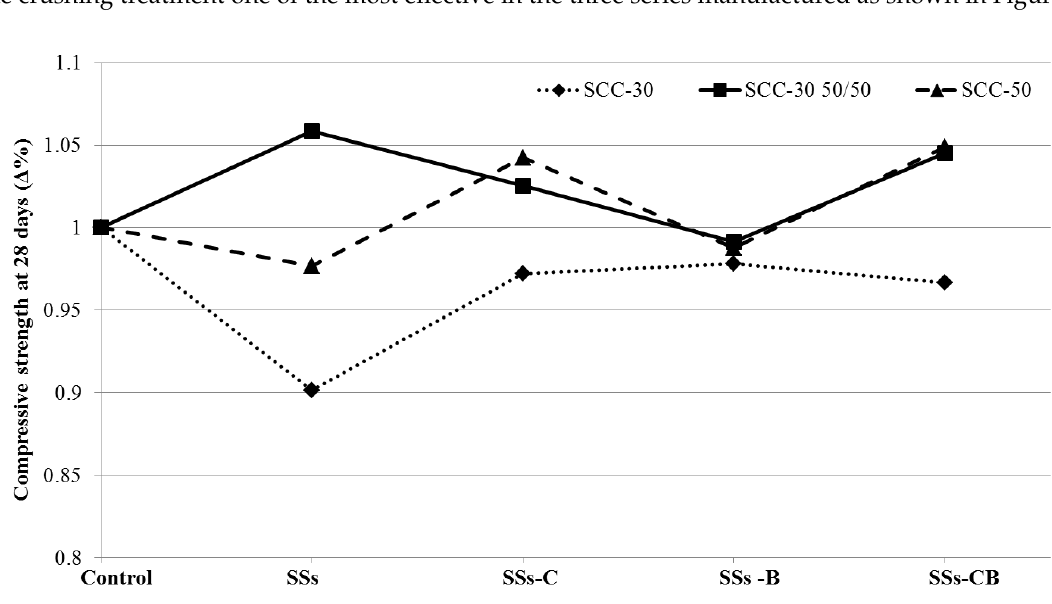
Figure 4. Relative compressive strength of SCC-30, SCC-30 50 / 50 and SCC-50 at 28 days versus control.